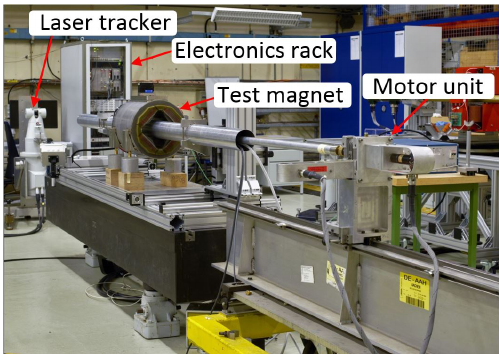
Figure 7. Measurement setup with all system components. The probe is inside the tube that goes through the